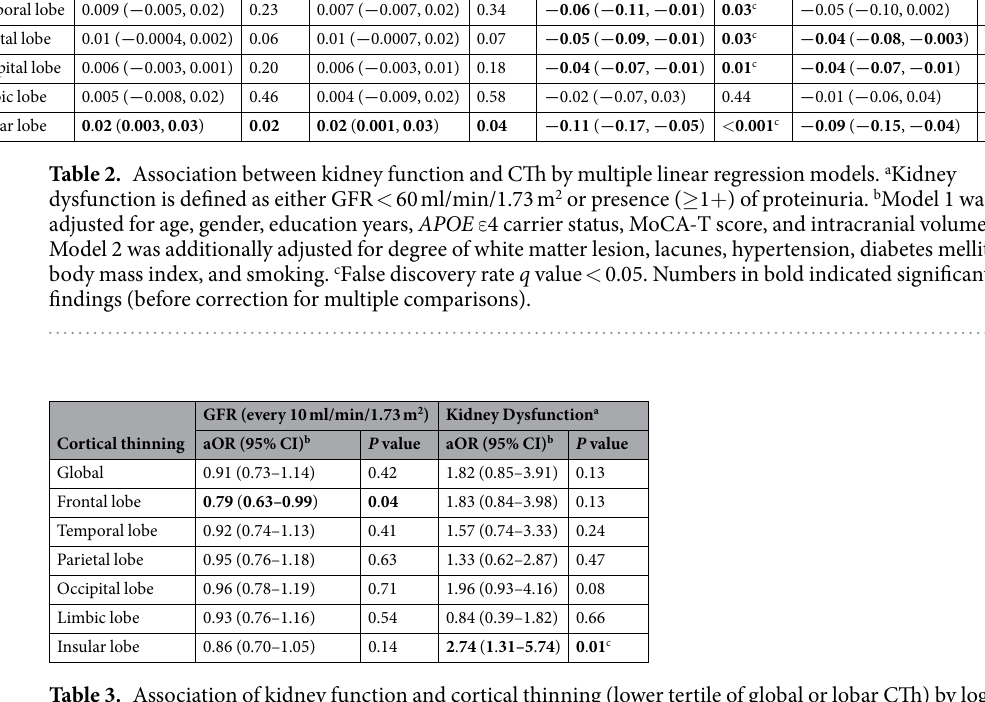
Table 3. Association of kidney function and cortical thinning (lower tertile of global or lobar CTh) by logistic regression models. a Kidney dysfunction is defined as either GFR < 60 ml/min/1.73 m 2 or presence ( ≥ 1 + ) of proteinuria. b The model was adjusted for age, gender, education years, APOE ε 4carrier status, MoCA-T score, and intracranial volume. c False discovery rate q value was 0.056. Numbers in bold indicated significant